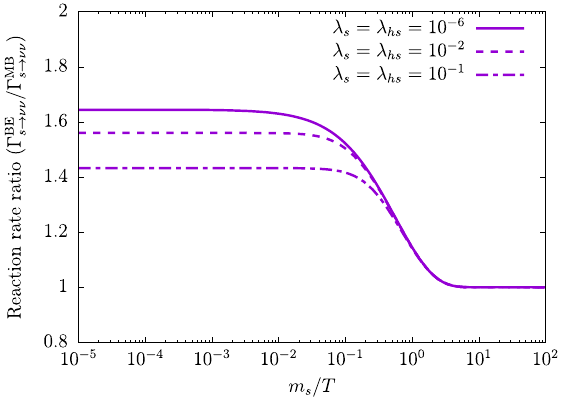
Figure 7 . Bose-Einstein vs Maxwell-Boltzmann s ! (cid:23)(cid:23) reaction